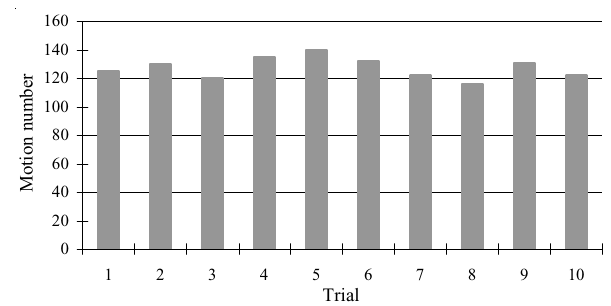
Figure 12 Motion number needed for text